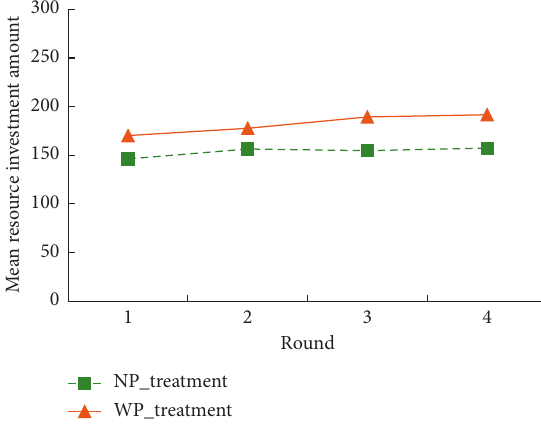
Figure 2: Mean resource investment amounts of enterprise